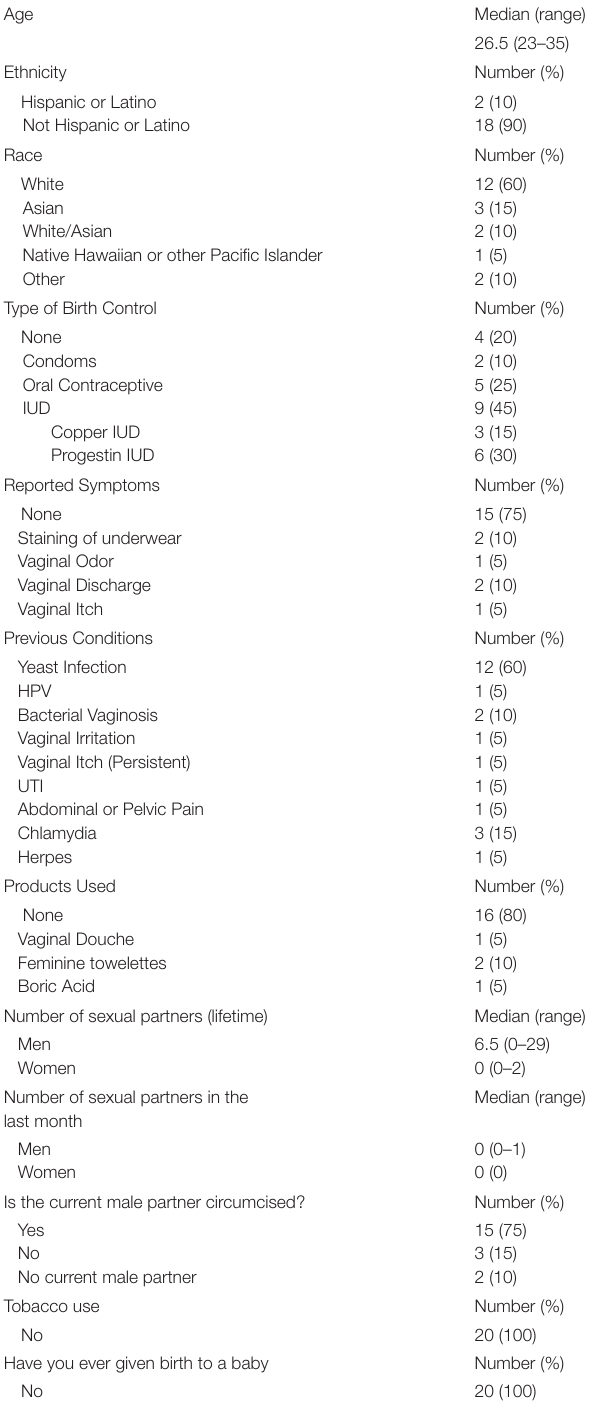
TABLE 1 | Participant demographics and questionnaire